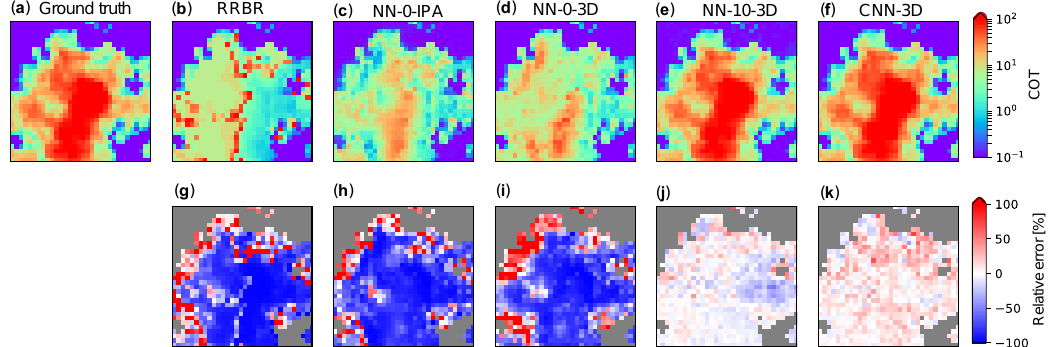
Figure 5. Examples of COT retrieval by various methods, namely: ( a ) ground-truth COT, ( b – f ) estimated COT, and ( g – k ) relative errors in the estimated COT. ( b , g ) The radiance red-to-blue ratio (RRBR) method of Mejia et al. (2016), ( c , h ) NN-0-IPA, ( d , i ) NN-0-3D, ( e , j ) NN-M10-3D, and ( f , k ) CNN-3D. The details of each NN / CNN-based estimation model are summarized in Table 1. This sample has a size of 32 × 32 pixels, and corresponds to the region marked by a red square in Figure 2. The direct solar beam is incident from the left, with a solar zenith angle of 60°.